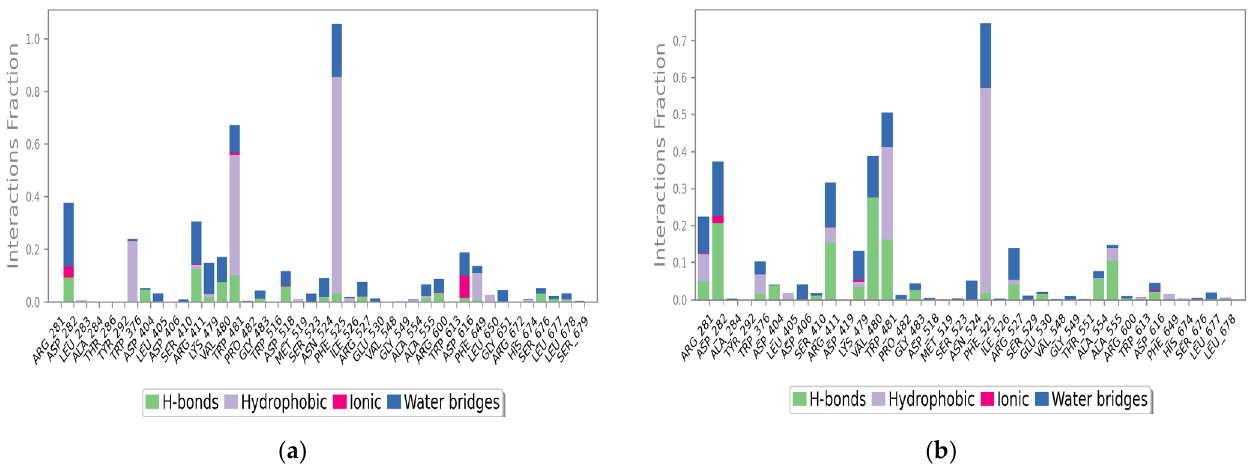
Figure 5. Type of interactions involved in MD simulation of Tradescantia pallida ’s compounds with human α -glucosidase protein 5NN5: ( a ) FTP1 and ( b ) FTP2; FTP1 is morin, FTP2 is catechin.